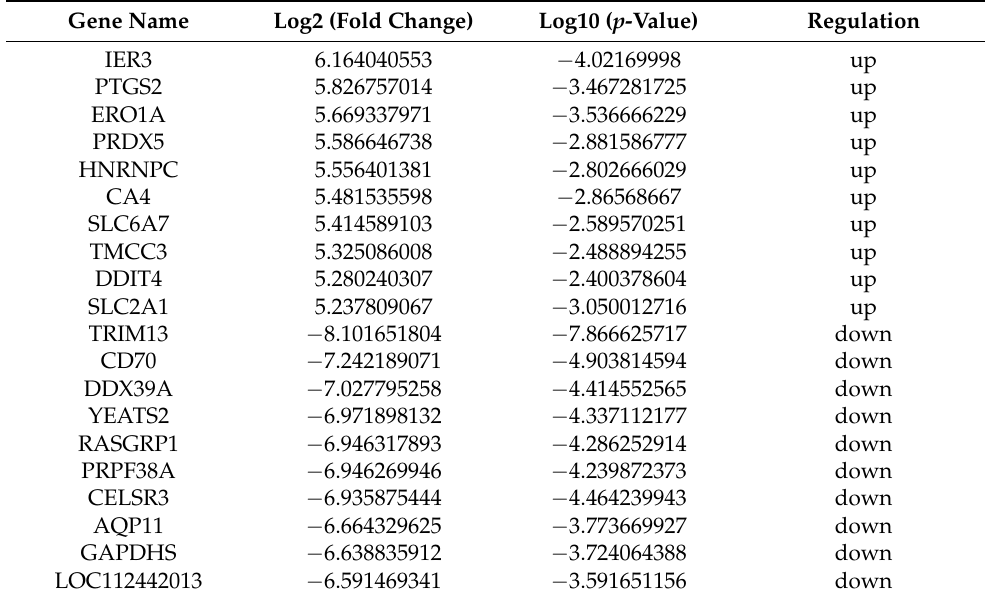
Figure 4. Biological function analysis of differential m 6 A modification according to GO biological processes (BPs) and KEGG pathways. The top 10 biological processes of hypermethylated mRNAs ( a ) and hypomethylated mRNAs ( b ) in the E. coli group. The top 10 enriched pathways of hypermethylated mRNAs ( c ) and hypomethylated mRNAs ( d ) in the E. coli group. Table 2. Top 20 differential mRNA expression in E. coli vs.